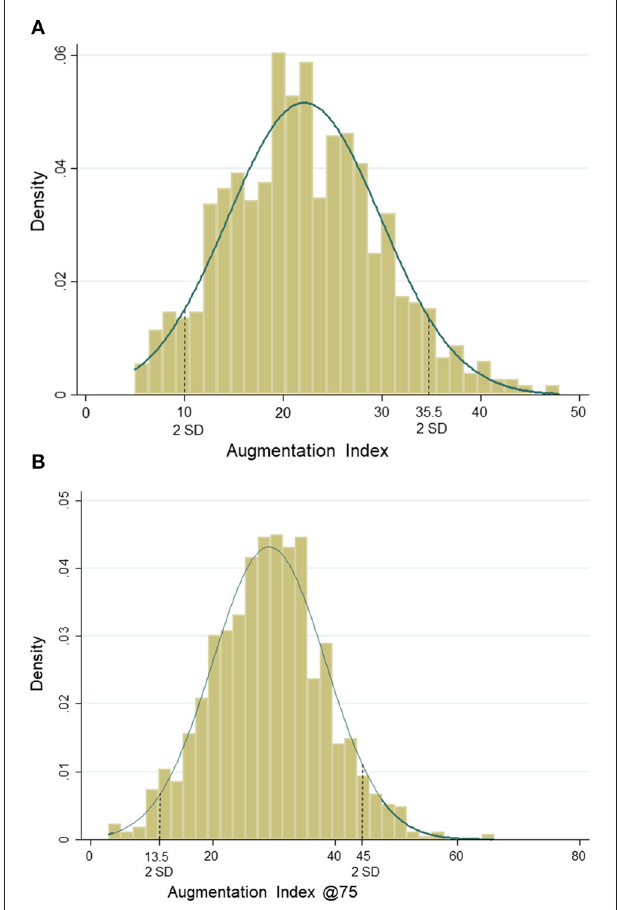
FIGURE 2 | (A) Normal distribution of augmentation index. (B) Normal distribution of augmentation